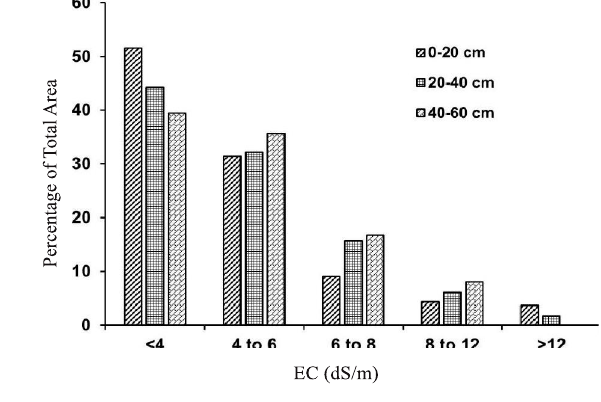
FIG. 8. PERCENTAGE OF TOTAL STUDY AREA WITH VARYING SOIL EC